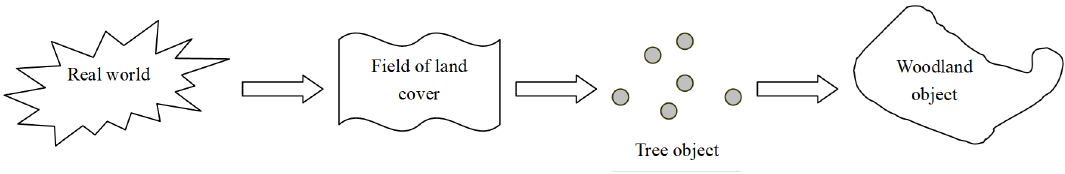
Figure 1. A three-phased conceptualization for woodland objects, using the field